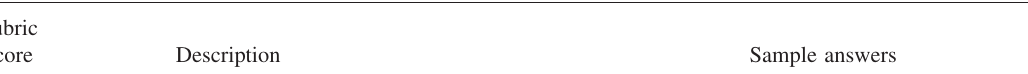
TABLE I. Rubric used to evaluate student responses to scientific argument question shown in Fig. 1. The sample answers are verbatim and representative. “Pre” and “Post” refer to whether the response was given prior to or after instruction. A, B, C, and D refer to the multiple choice response given to the